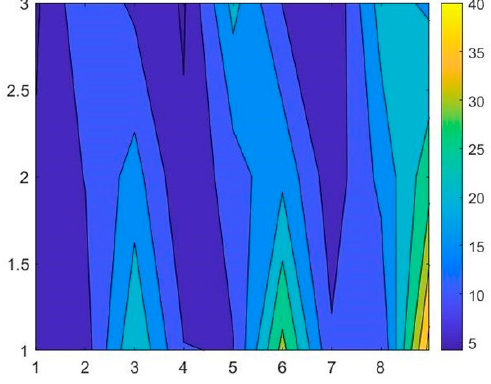
Figure 14. Contour plots of experimental data.